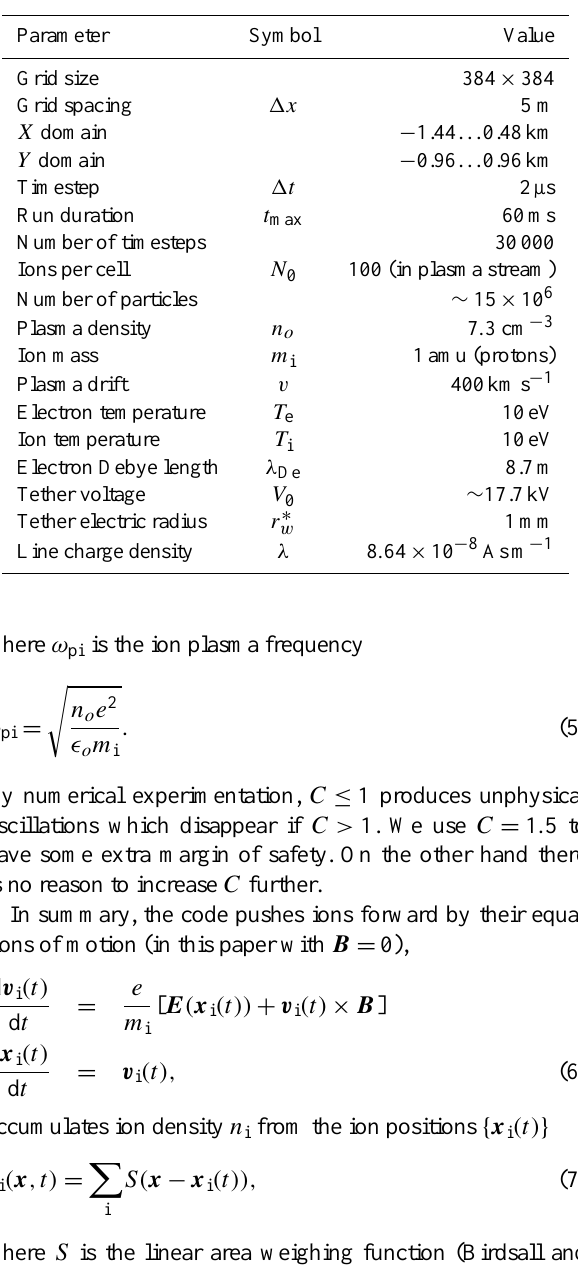
Table 1. Simulation parameters (high-resolution runs). For defini- tion of tether electric radius r ∗ w , see Janhunen and Sandroos